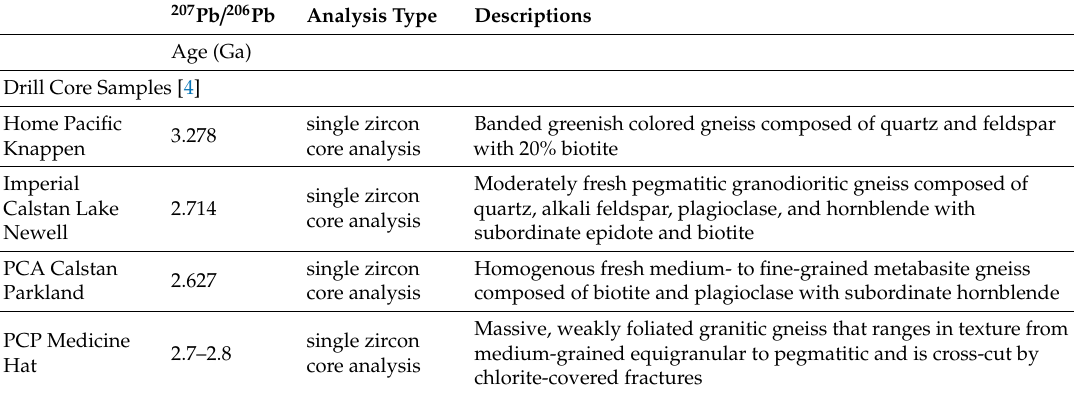
Table 1. Published zircon U-Pb ages, analysis type, and sample descriptions of drill cores from Villeneuve et al. [4]. Published zircon U-Pb ages, analysis type, and sample descriptions of xenoliths are from Davis et al.